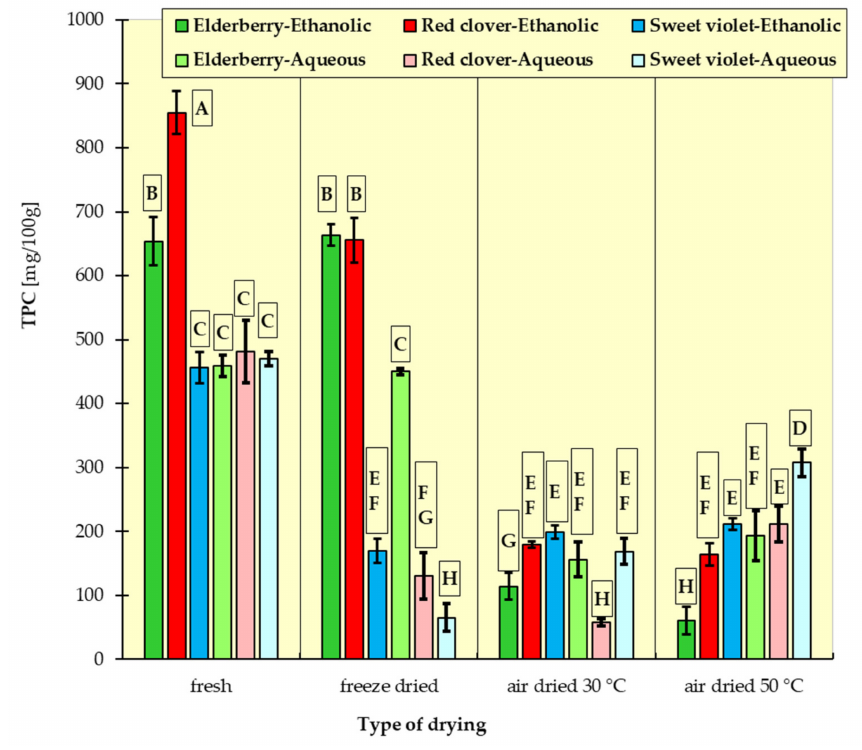
Figure 1. Total polyphenol content (TPC) in ethanolic and aqueous extracts from red clover,